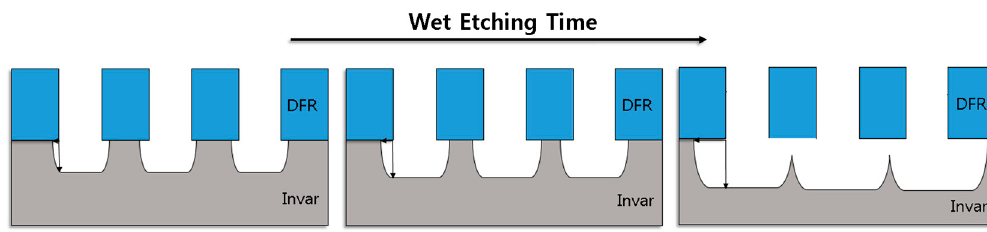
Figure 3. Invar film wet etching isotropic characteristics.